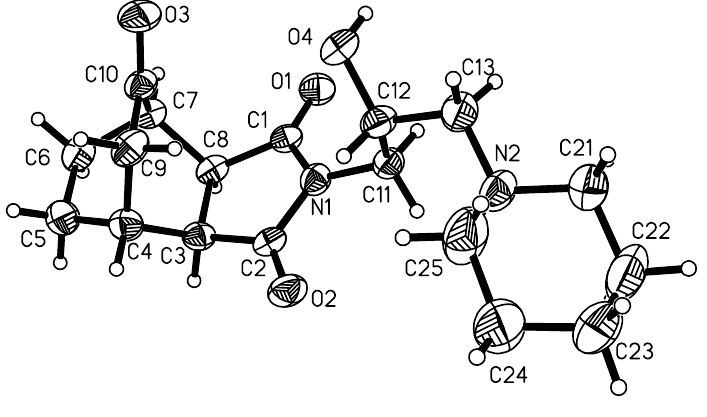
Figure 3. Molecular structure of product 5e . Selected bond lengths: O1-C1 1.199(6), O2